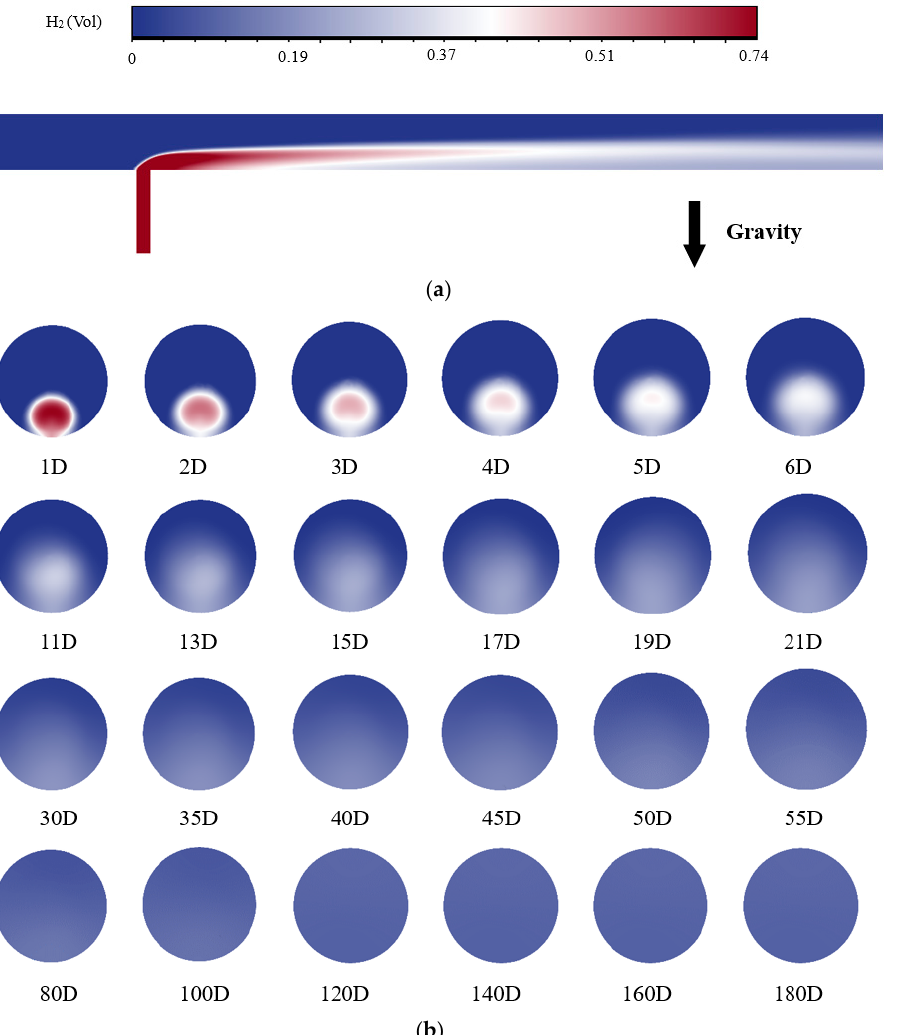
Figure 6. Distribution of hydrogen concentration in natural gas pipeline ( v CH = 2.78 m/s, HBR = 10%, p = 0.3 MPa, T = 300 K, and d / D = 0.2). ( a ) Distribution of hydrogen concentration on YZ slice of natural gas pipeline. ( b ) Distribution of hydrogen concentration on different cross sections of natural gas pipeline.